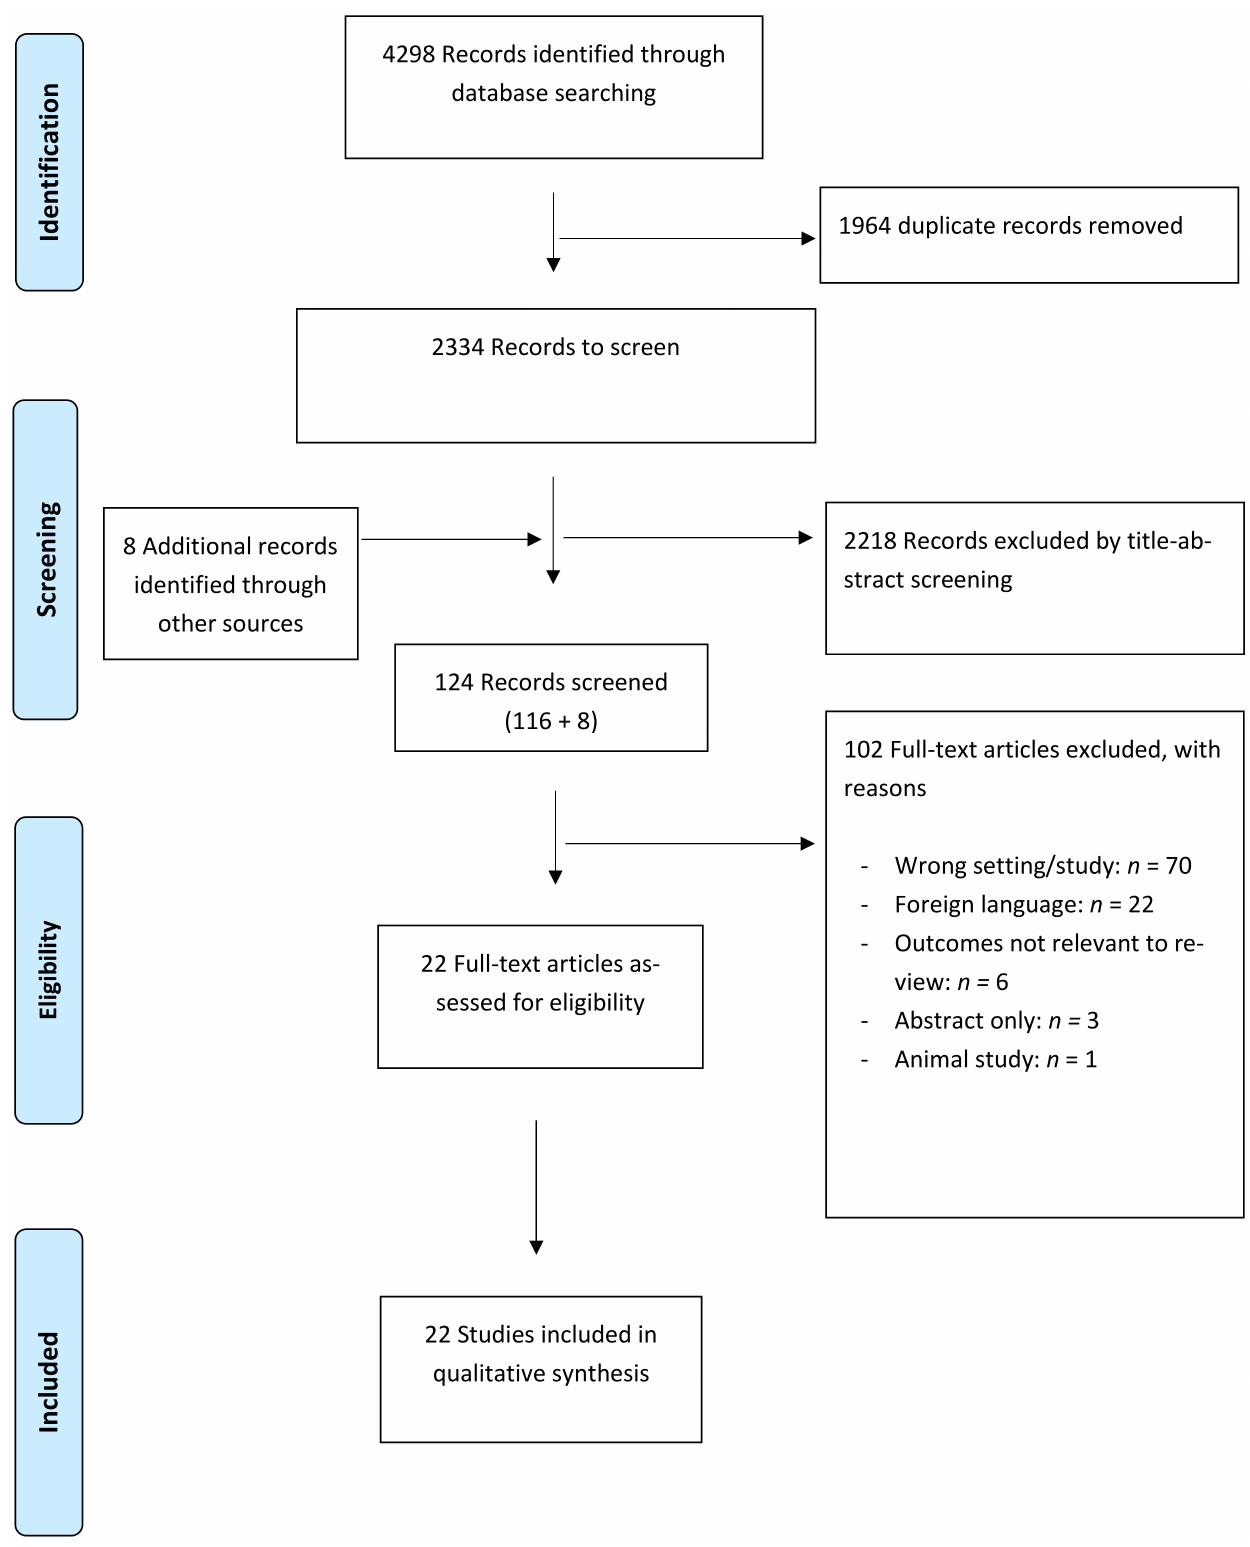
Figure A2. PRISMA flow